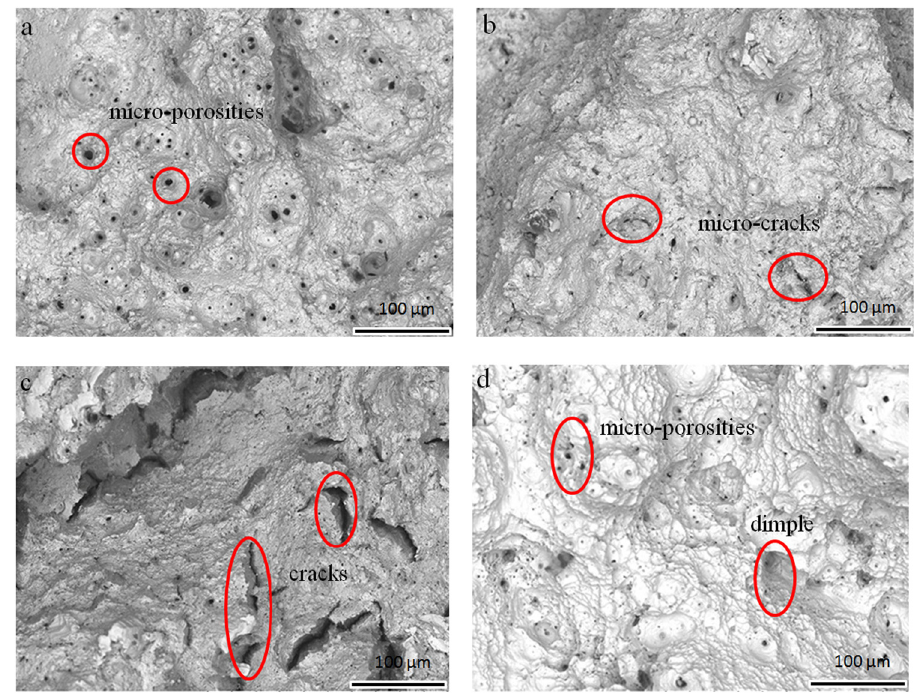
Figure 9: The microscopic morphology of fracture at 350°C: ( a ) 30CrMo, ( b ) 42CrMo, ( c ) 1Cr13, and ( d ) 304